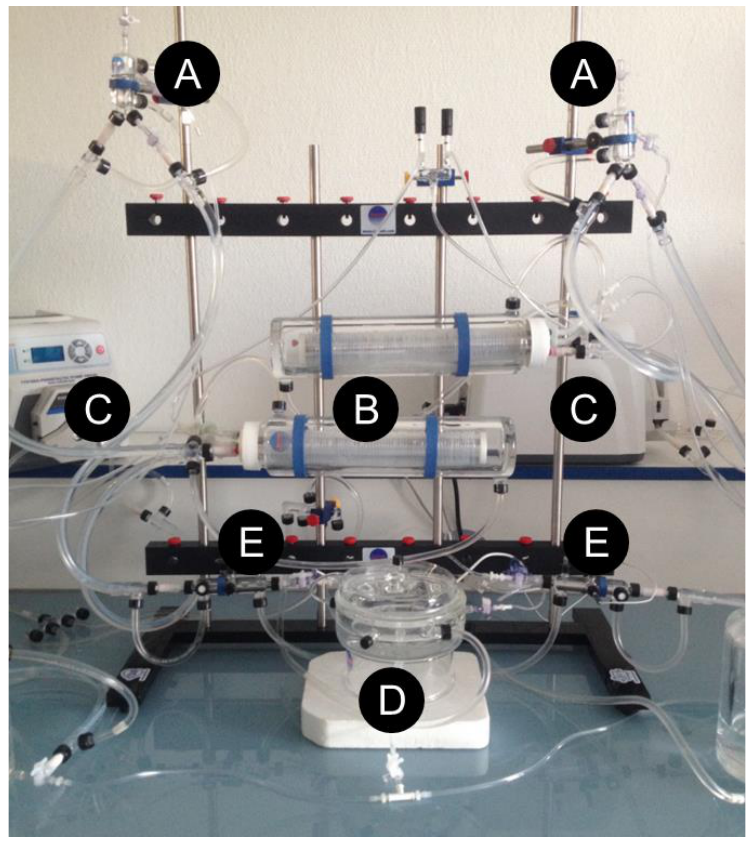
Figure 10. Experimental ex vivo machine perfusion system. Ex vivo machine perfusion system is adapted from liver/kidney systems ( A ) Bubble trap; ( B ) Membrane oxygenating; ( D ) Liver perfusion chamber (Radnoti LLC, Covina, CA, USA) assembled by the author (NA) ( C ) Peristaltic pump (MasterFlex ® , Thermo Fisher Scientific, Waltham, MA, USA); ( E ) Flow sensor (TS410 Tubing Module, Transonic Systems Inc., Ithaca, NY, USA), a water bath circulator pump (9102A12E, 6-liter High- Stability Digital Controller Refrigerated/Heated Circulating Bath, Polyscience, Niles, IL, USA), and an oxygen bottle (95% O 2 /5% CO 2 , Air Liquide, Paris, France).